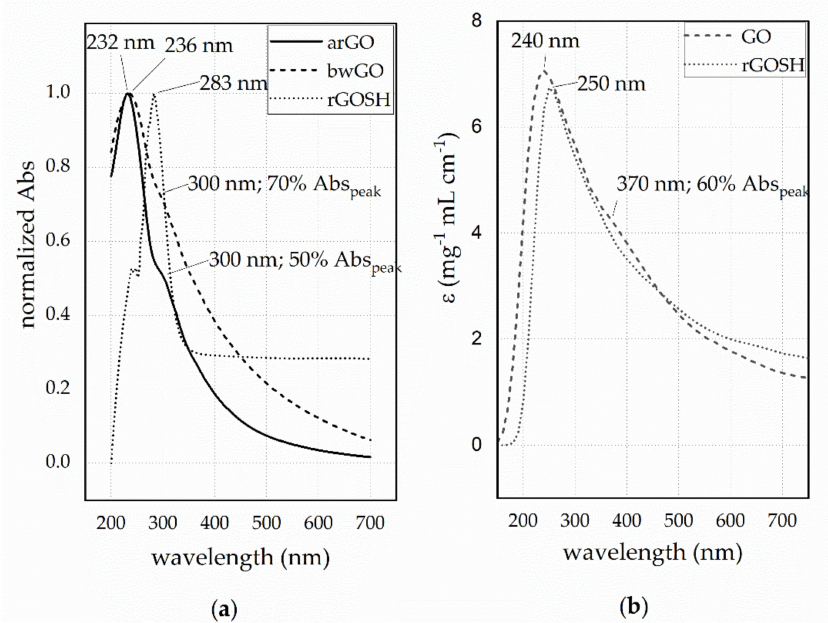
Figure 1. ( a ) Experimental UV-VIS spectra normalized to the π → π * absorbance peak of as-received graphene oxide (arGO, in water, solid line), base-washed GO (bwGO, in water, dashed line), and thiolated reduced GO (rGOSH, in dimethyl sulfoxide DMSO, dotted line). ( b ) Theoretical UV-VIS spectra of GO and rGOSH from semi-empirical computational